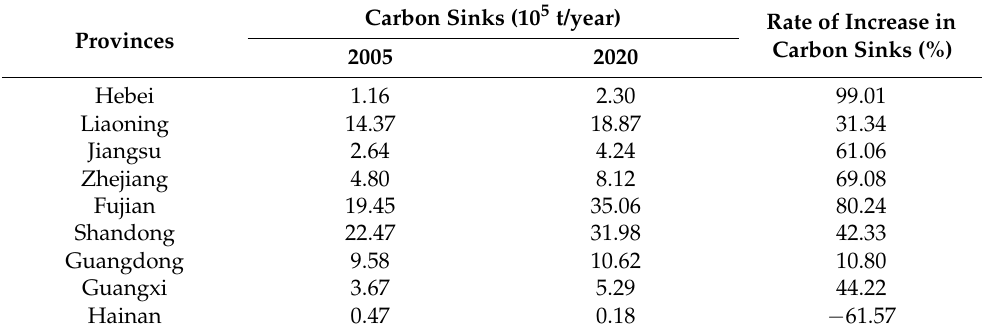
Table 4. Increased carbon sinks of the marine